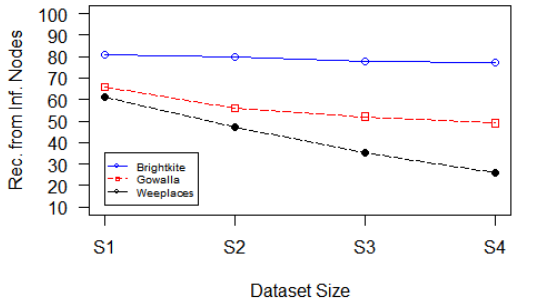
Figure 10. Recommendation from influential